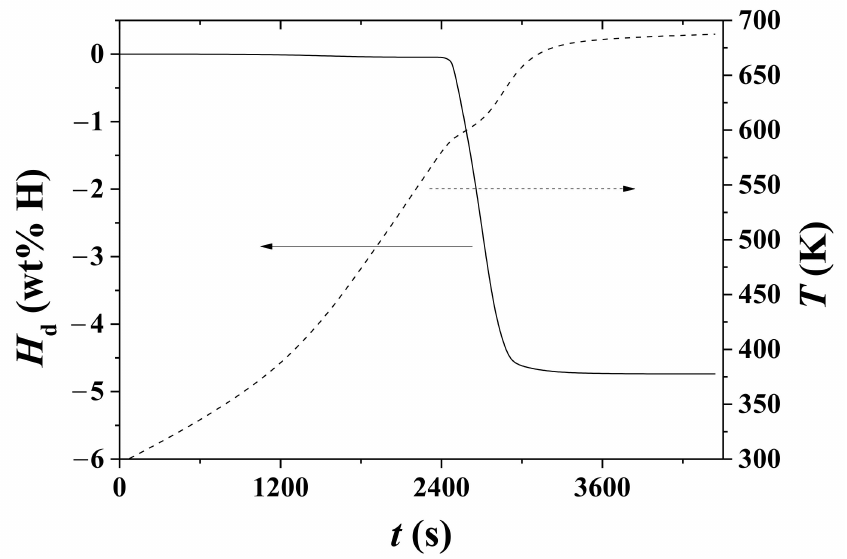
Figure 6. Variations in H d and T with t under 1.0 bar H 2 for hydrided Mg–5Ni. The sample was heated with a heating rate of 9